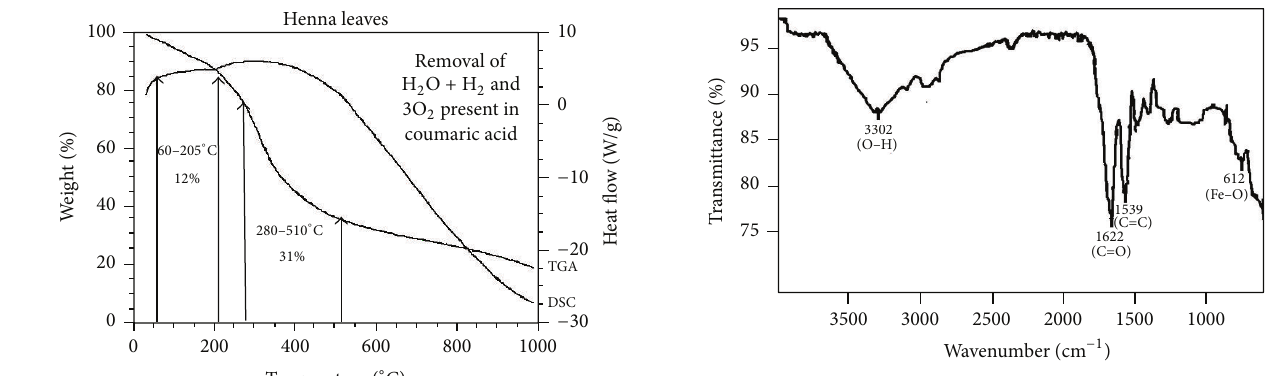
Figure 1: TGA of FeNPs synthesized using Henna leaves extract.